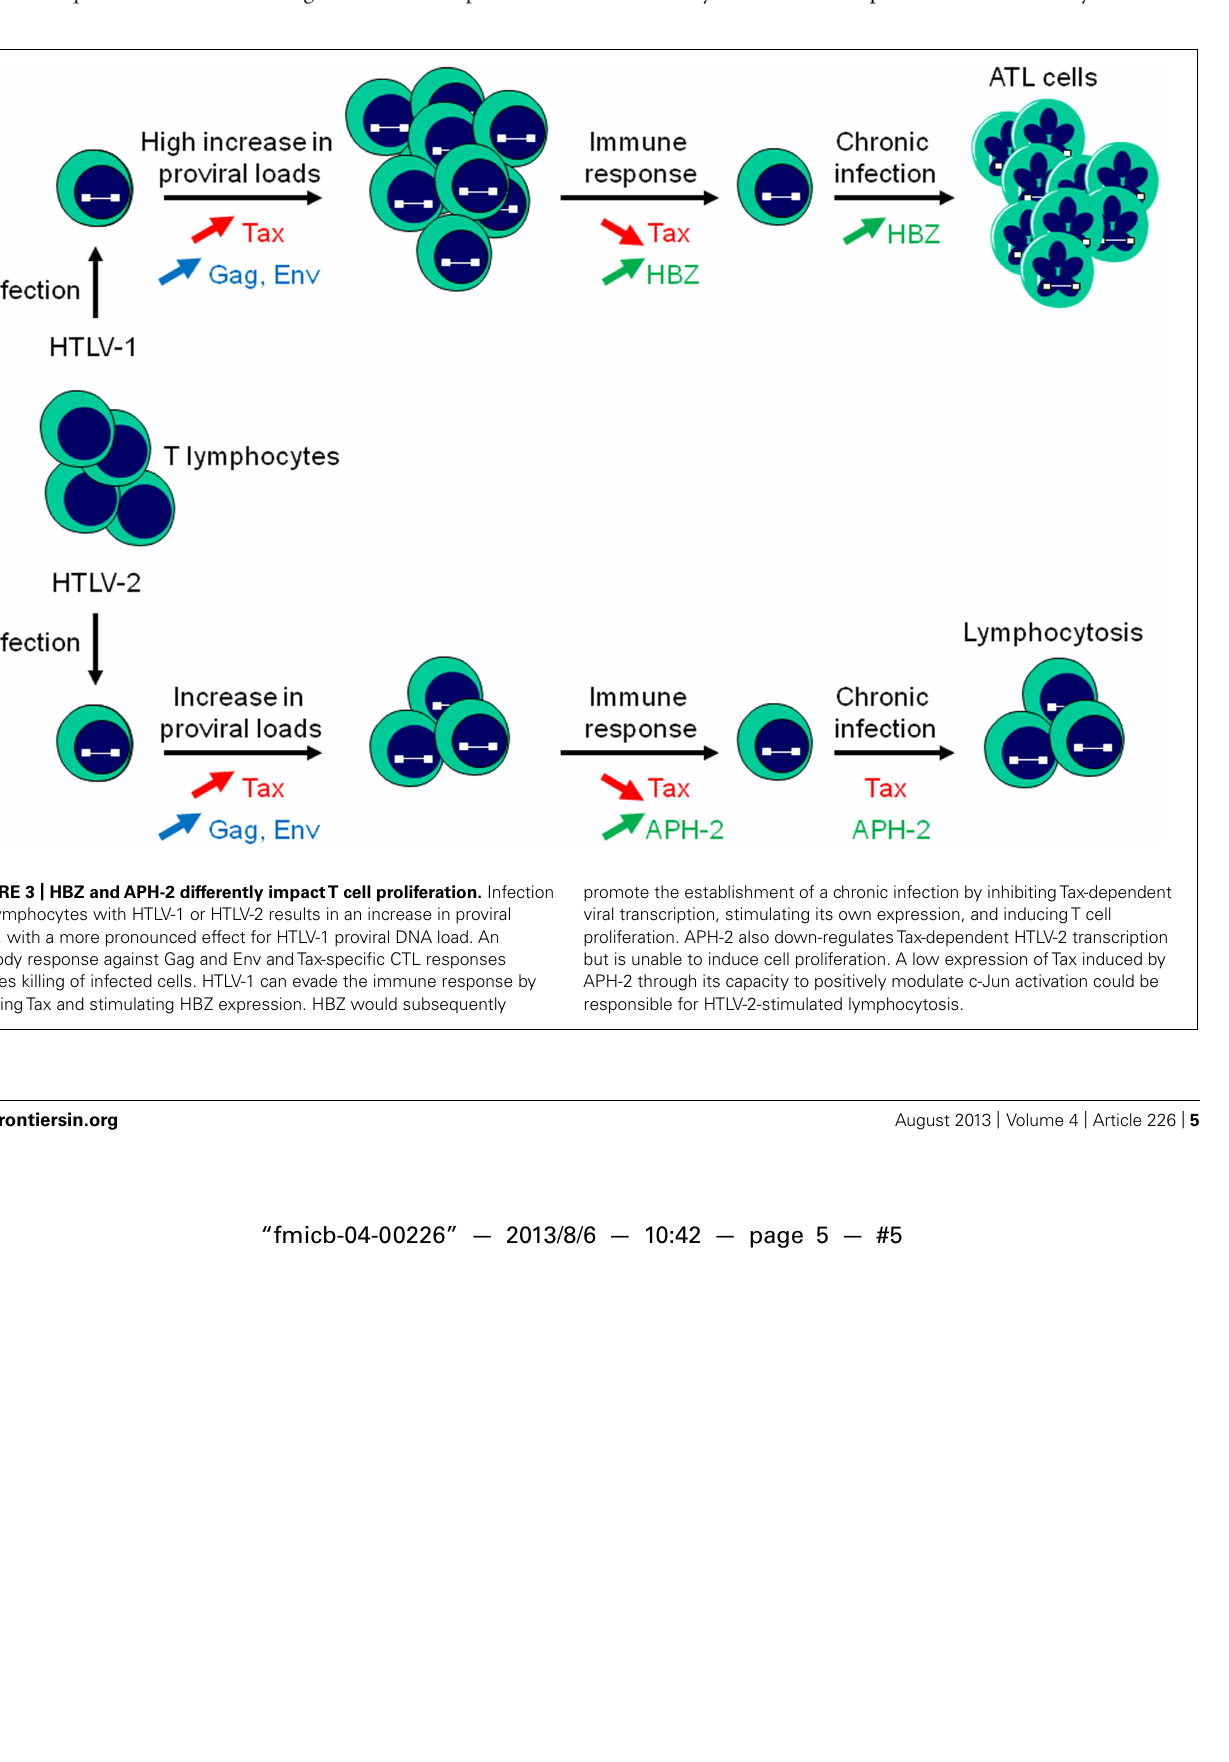
FIGURE 3 | HBZ andAPH-2 differently impactT cell proliferation. Infection ofT lymphocytes with HTLV-1 or HTLV-2 results in an increase in proviral loads, with a more pronounced effect for HTLV-1 proviral DNA load. An antibody response against Gag and Env andTax-specific CTL responses induces killing of infected cells. HTLV-1 can evade the immune response by reducingTax and stimulating HBZ expression. HBZ would subsequently